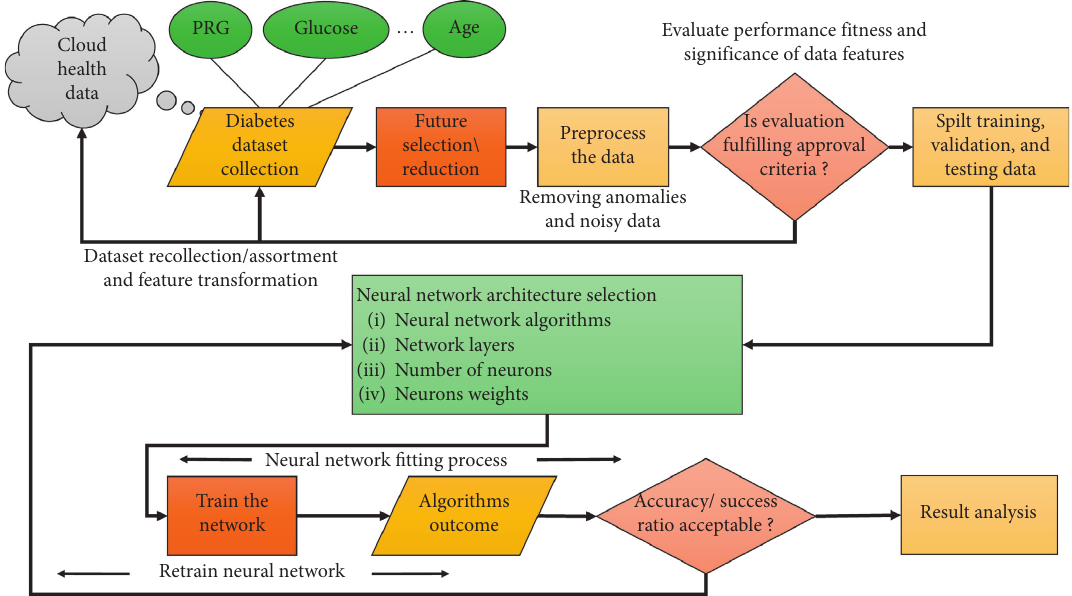
Figure 1: The proposed framework of diabetes prediction using neural network architecture